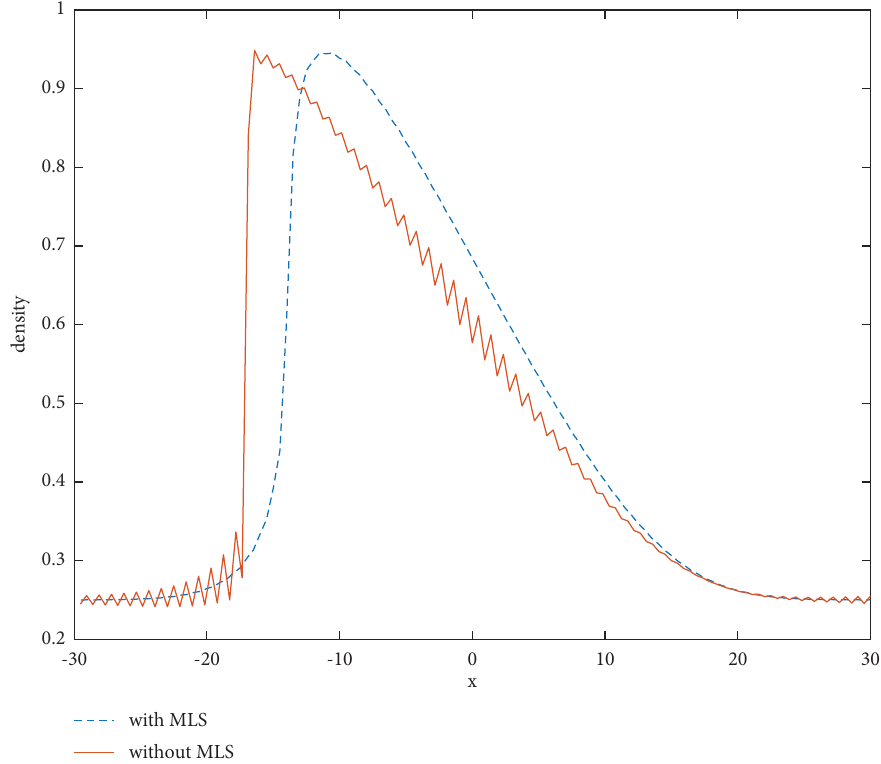
Figure 5: A comparison of the solution of equation of example 1 using the present method with the solution without MLS. Table 1: A comparison of the solution of equation of example 1 using the present method with other numerical